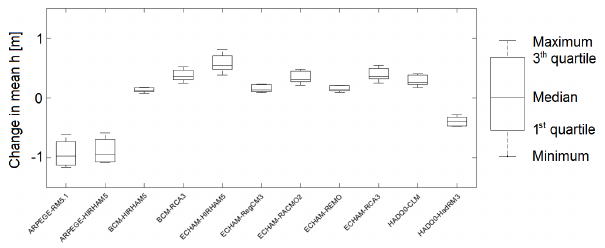
Figure 4. Simulated change in mean hydraulic head of the lime- stone aquifer in the focus area using six geological models and 11 climate